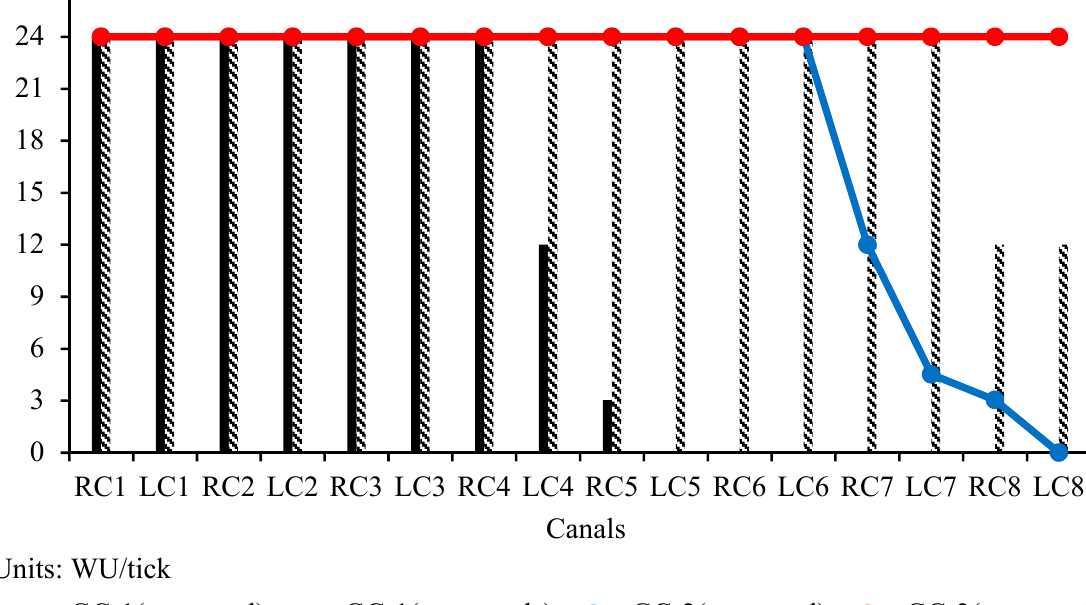
Figure 5. Yields per farmer with sufficient water under Time Control with different irrigation times: (a) Farmers’ yields when IT = 1 day; (b) Farmers’ yields when IT = 1.5 days; (c) Farmers’ yields when IT = 2 days; (d) Farmers’ yields when IT = 3 days; (e) Farmers’ yields when IT = 3.5 days. 3.2. Abundant Water Availability